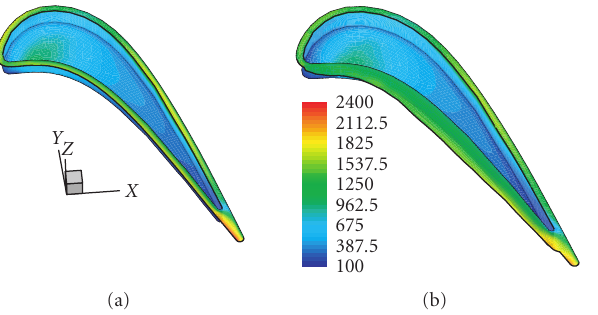
Figure 11: Contours of heat transfer coe ffi cient on blade tip, (a) baseline squealer tip and (b) desensitized squealer tip.